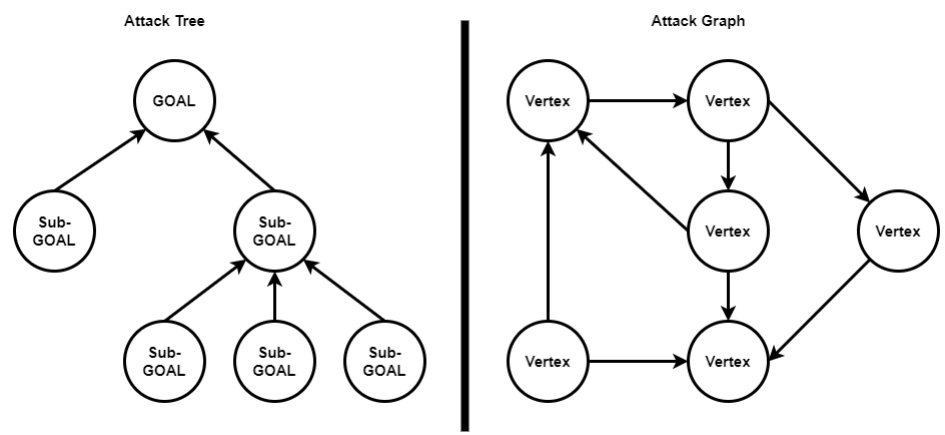
Figure 10. Concept of an attack tree vs. attack